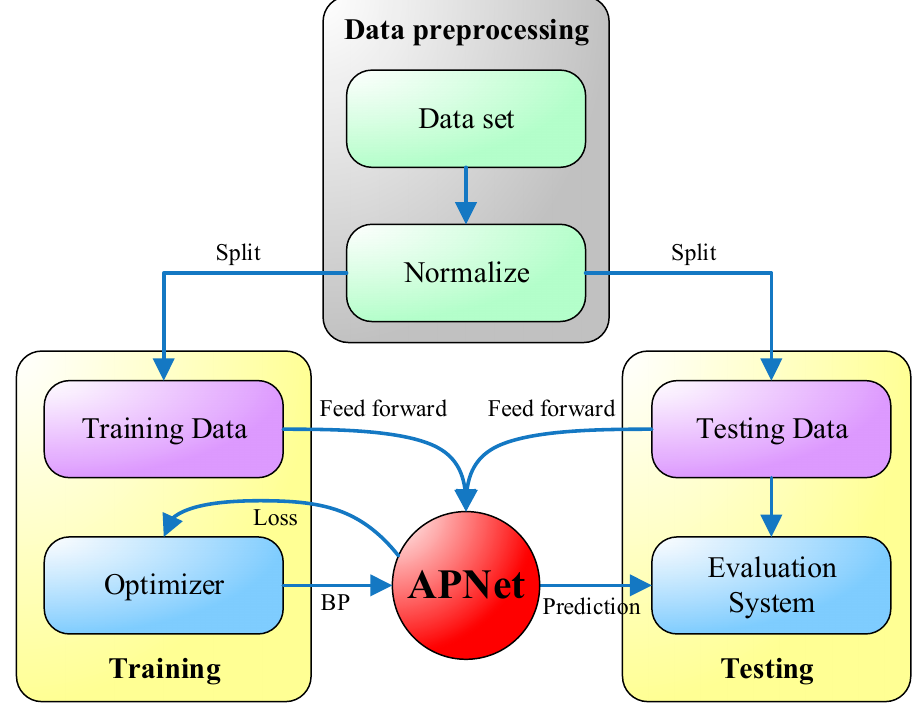
Figure 6. The system flow diagram of the proposed APNet.